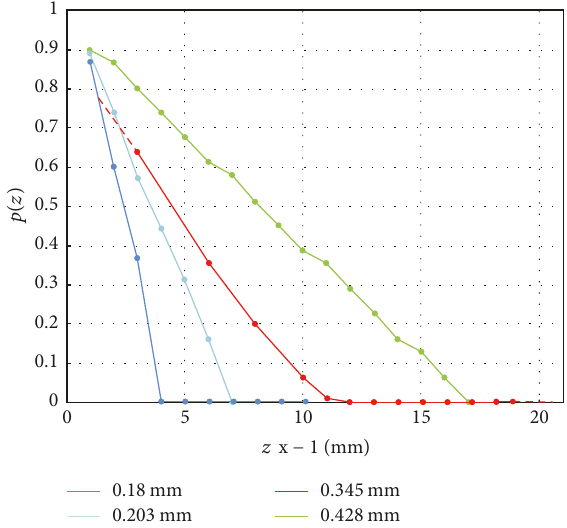
Figure 6: Probability 𝑝(𝑧) of the secondary electrons’ passage through the penetration channel from depth 𝑧 for channels with differing